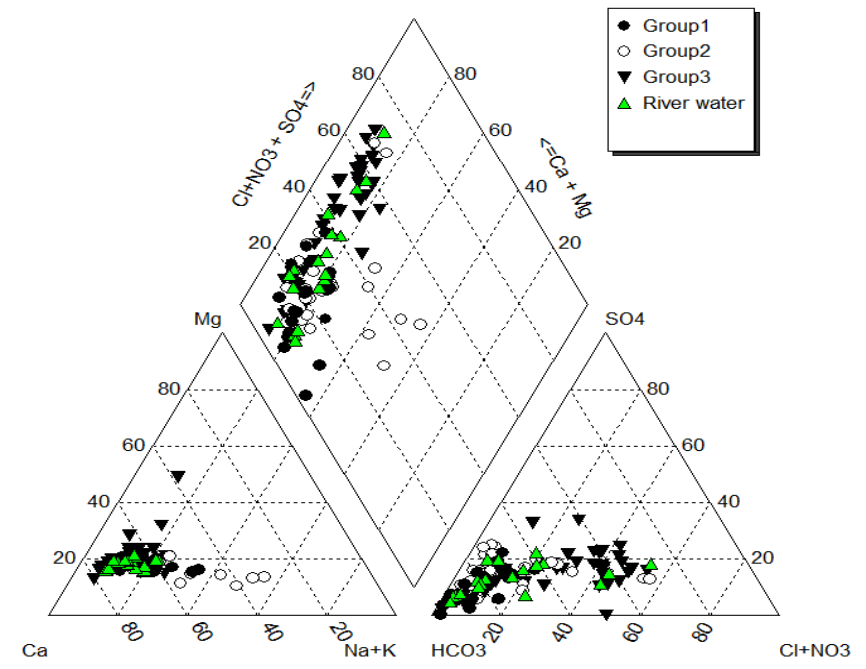
Figure 5. Piper diagrams of the chemical compositions of groundwater and surface water in UB.